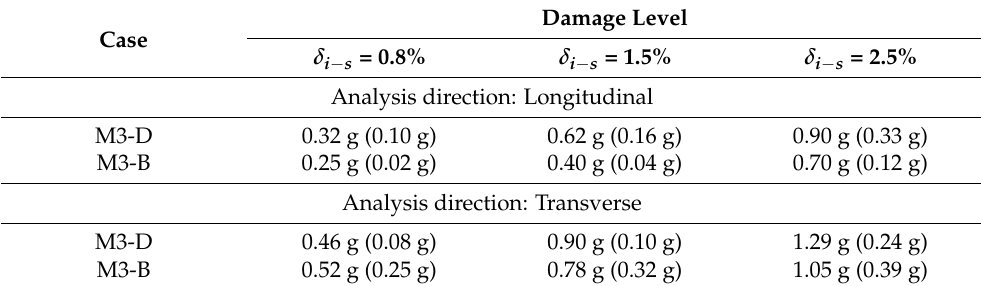
Table 8. Mean and standard deviation (between brackets) values of the log-normal fragility curves.